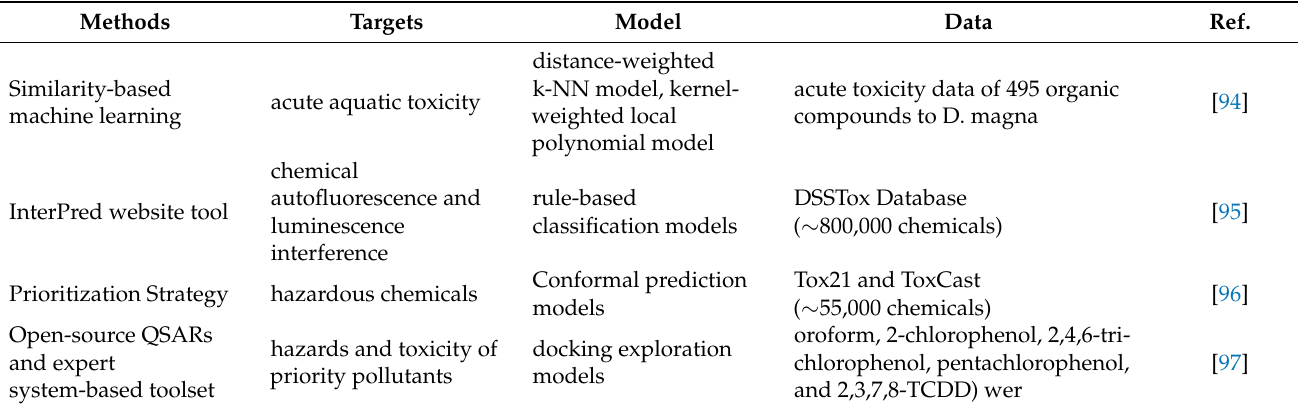
Table 1. Current Prediction Modeling